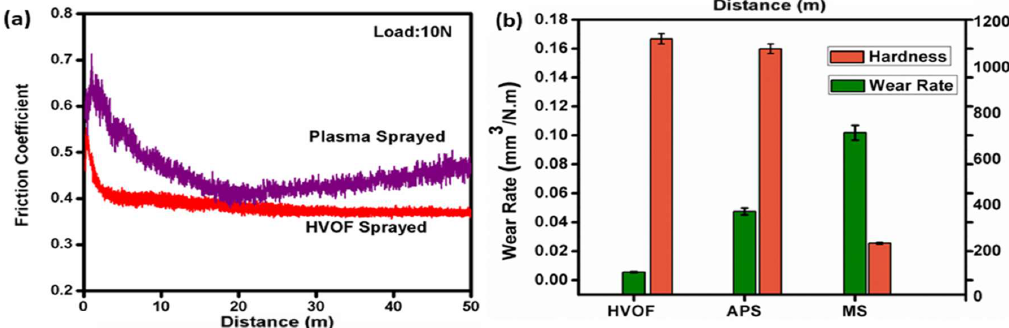
Figure 6. ( a ) Friction coefficient of iron-based amorphous coating. ( b ) Hardness and wear rate of iron- based amorphous coatings and steel substrate.